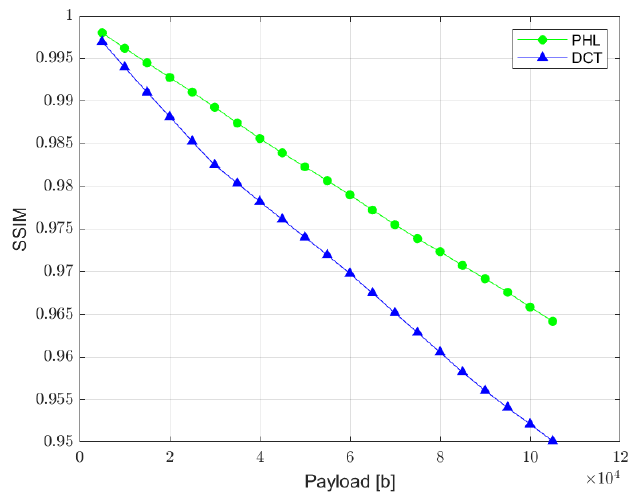
Figure 11. Relation between SSIM metric and the watermark capacity (PHL vs. DCT).